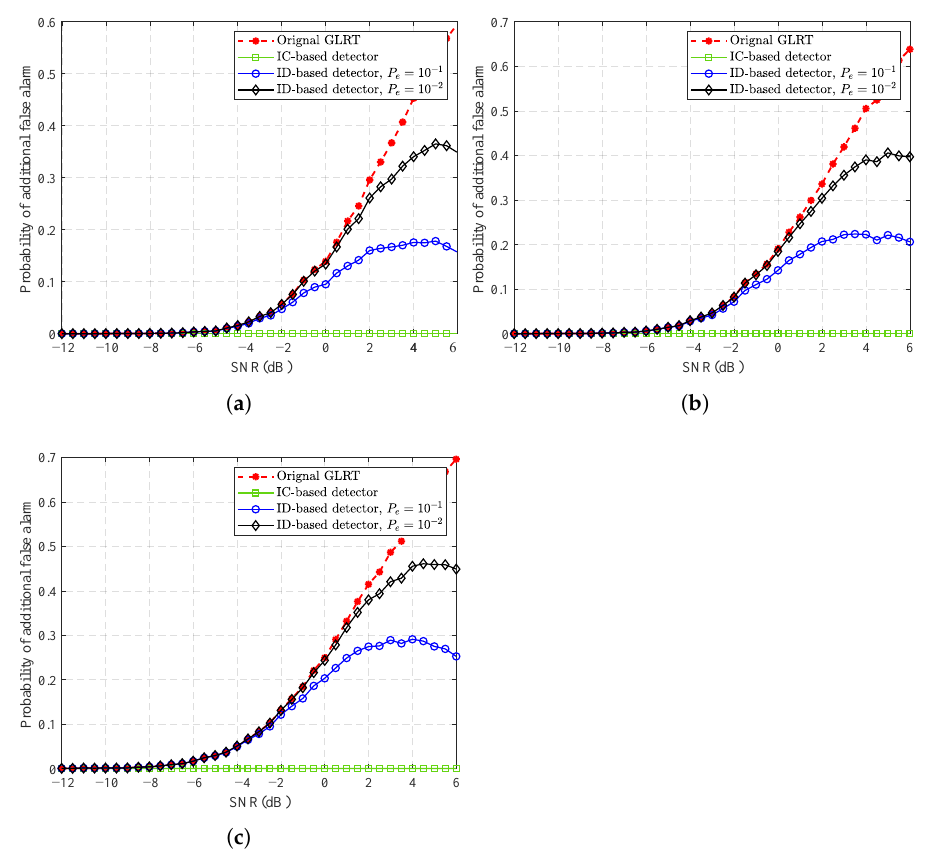
Figure 14. Probability of additional false alarm κ = 1. ( a ) P fa = 10 − 6 . ( b ) P fa = 10 − 5 . ( c ) P fa = 10 − 4